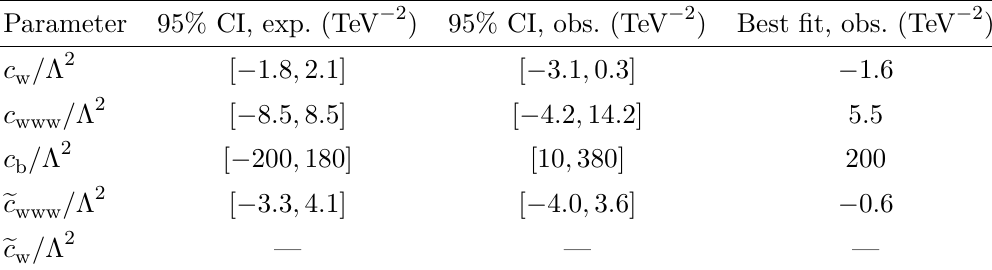
— — — Table 13 . Best fit, and expected and observed one-dimensional confidence intervals at 95% confi- dence level for each of the considered EFT parameters. Only the dimension-six interference term is included to compute the EFT effect in the high tails of M (WZ) for these results. In computing confidence intervals for each parameter the other ones are fixed to their SM values. The — symbol means no sensitivity is observed for the interference only term for the c e w